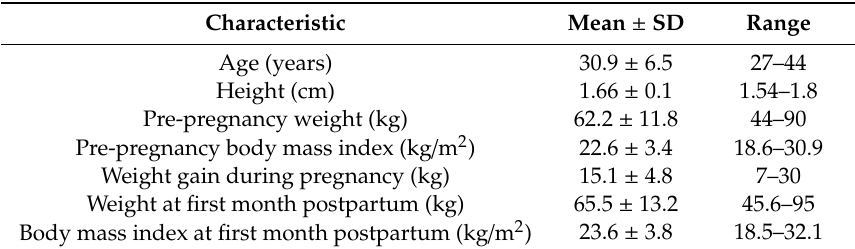
Table 1. Characteristics of the mothers.